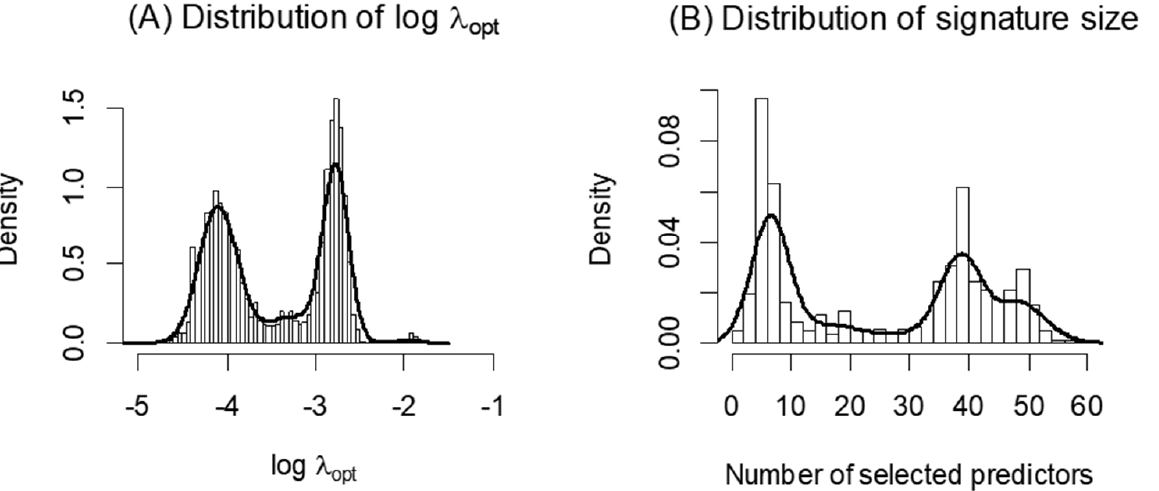
Figure 1. Distribution of λ opt ( A ) across 1000 runs of glmnet is shown, along with the distribution of the corresponding number of predictors in the signatures ( B ). Each application of the glmnet algorithm for this dataset results in an optimal signature, with size varying greatly from less than 5 to over 50 predictors.